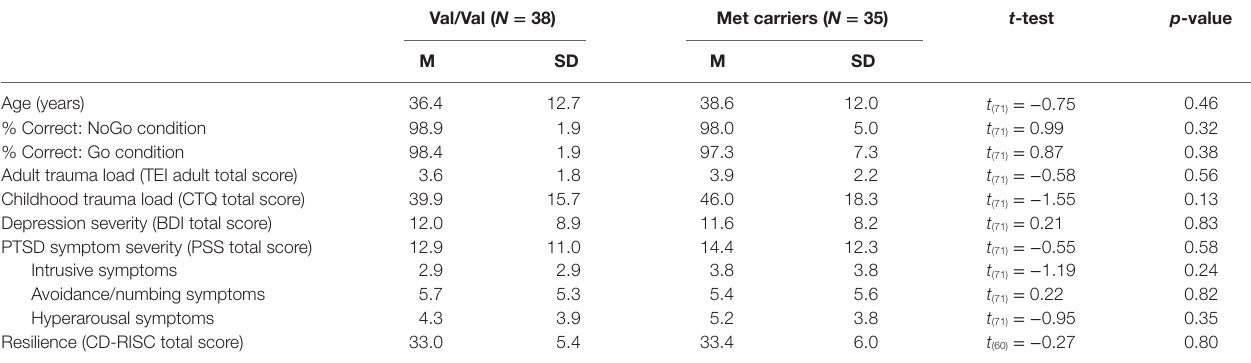
TaBle 1 | clinical and demographic characteristics of the Val/Val and Met carriers group.